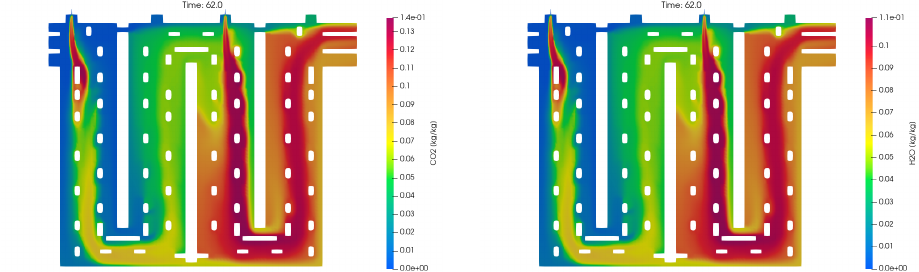
Figure 9. Mass fraction of CO 2 ( left ) and H 2 O ( right ) on the symmetry plane at t = 62 s of computa- tion